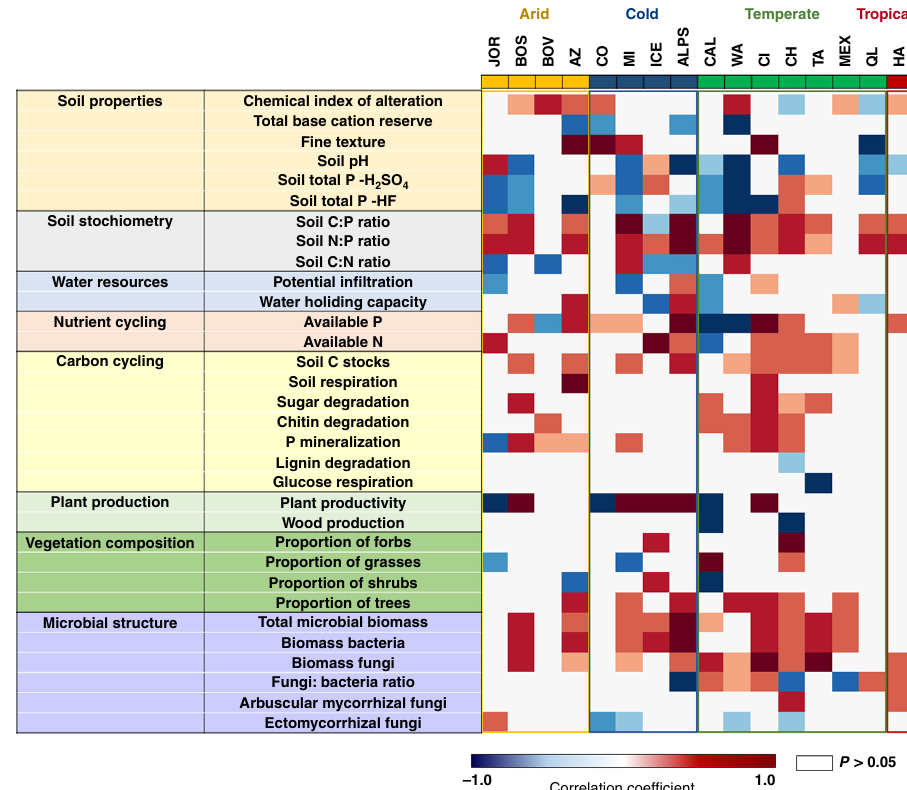
Fig. 10 Changes in the structure and function of terrestrial ecosystems during ecosystem development. Correlations (Spearman) among chronosequence stage and ecosystem properties. See Fig. 1 for the location and acronyms of these chronosequences. Statistically non-signi fi cant correlations ( P > 0.05) are shown in white. Numeric values and n for all correlations are in Supplementary Table 6. Detailed information on the n , units, rationale, descriptions, and acronyms for these functional and structural properties are in Supplementary Table 3. The chemical index of alteration (CIA) and the total base cation reserves (TBR) indices provide information on the relative extent of ( ρ = 0.90; P < 0.001, n = 435) across samples, so we kept only soil C for statistical modeling. Soil respiration was determined on composite soil samples per plot by quantifying the CO 2 released during 16 days from 1g of soil sample incubated at 28°C at 50% of water-holding capacity in 20-mL glass vials in the dark, following a 1-week pre-incubation 37 . We measured three extracellular enzyme activities in all soil samples: activity of β -glucosidase (sugar degradation), N -acetylglucosaminidase (chitin degradation), phosphatase (phosphorus mineralization). Extracellular soil enzyme activities were measured using 1g of soil by fl uorometry 38 . We also determined substrate-induced respiration rates for lignin (lignin degradation) using the Microresp protocol 39 . In brief, samples with and without (basal respiration) lignin were incubated for 6h and read at 570 nm. Lignin degradation was calculated as respiration in lignin less the basal respiration. Finally, the respiration of glucose was assayed through the incubation of soils in the above conditions for soil respiration (28°C and 50% of water-holding capacity) and addition of 240 µg of 13 C-glucose (99 atom% U- 13 C, Cambridge Isotope Laboratories, Tewksbury, Massachusetts, USA) dissolved in water to each vial 40 . CO 2 production and its isotopic composition were then measured as described in ref. 40 . Plant production and vegetation composition . We used the Normalized Dif- ference Vegetation Index (NDVI) as our proxy for net plant primary productivity. This index provides a global measure of the “ greenness ” of vegetation across Earth ’ s landscapes for a given composite period, and thus acts as a proxy of photosynthetic activity and large-scale vegetation distribution. NDVI data were obtained from the Moderate Resolution Imaging Spectroradiometer (MODIS) aboard NASA ’ s Terra satellites (http://neo.sci.gsfc.nasa.gov/). We obtained plant productivity information (averaged monthly values between 2008 and 2017) at a resolution of 250 m. Within each 50 × 50m plot, three 50-m parallel transects were established, spaced 25m apart. The relative abundance of woody vs. non-woody plants was calculated using vegetation transect information, and used as a surrogate of the availability of wood resources (Supplementary Table 3). The percentage of cover by trees, shrubs, open areas, forbs, and grasses was measured in each of the three transects located within each plot (see above) using the line-intercept method 21 . The dominant vegetation in each location is available in Supplementary Table 1.